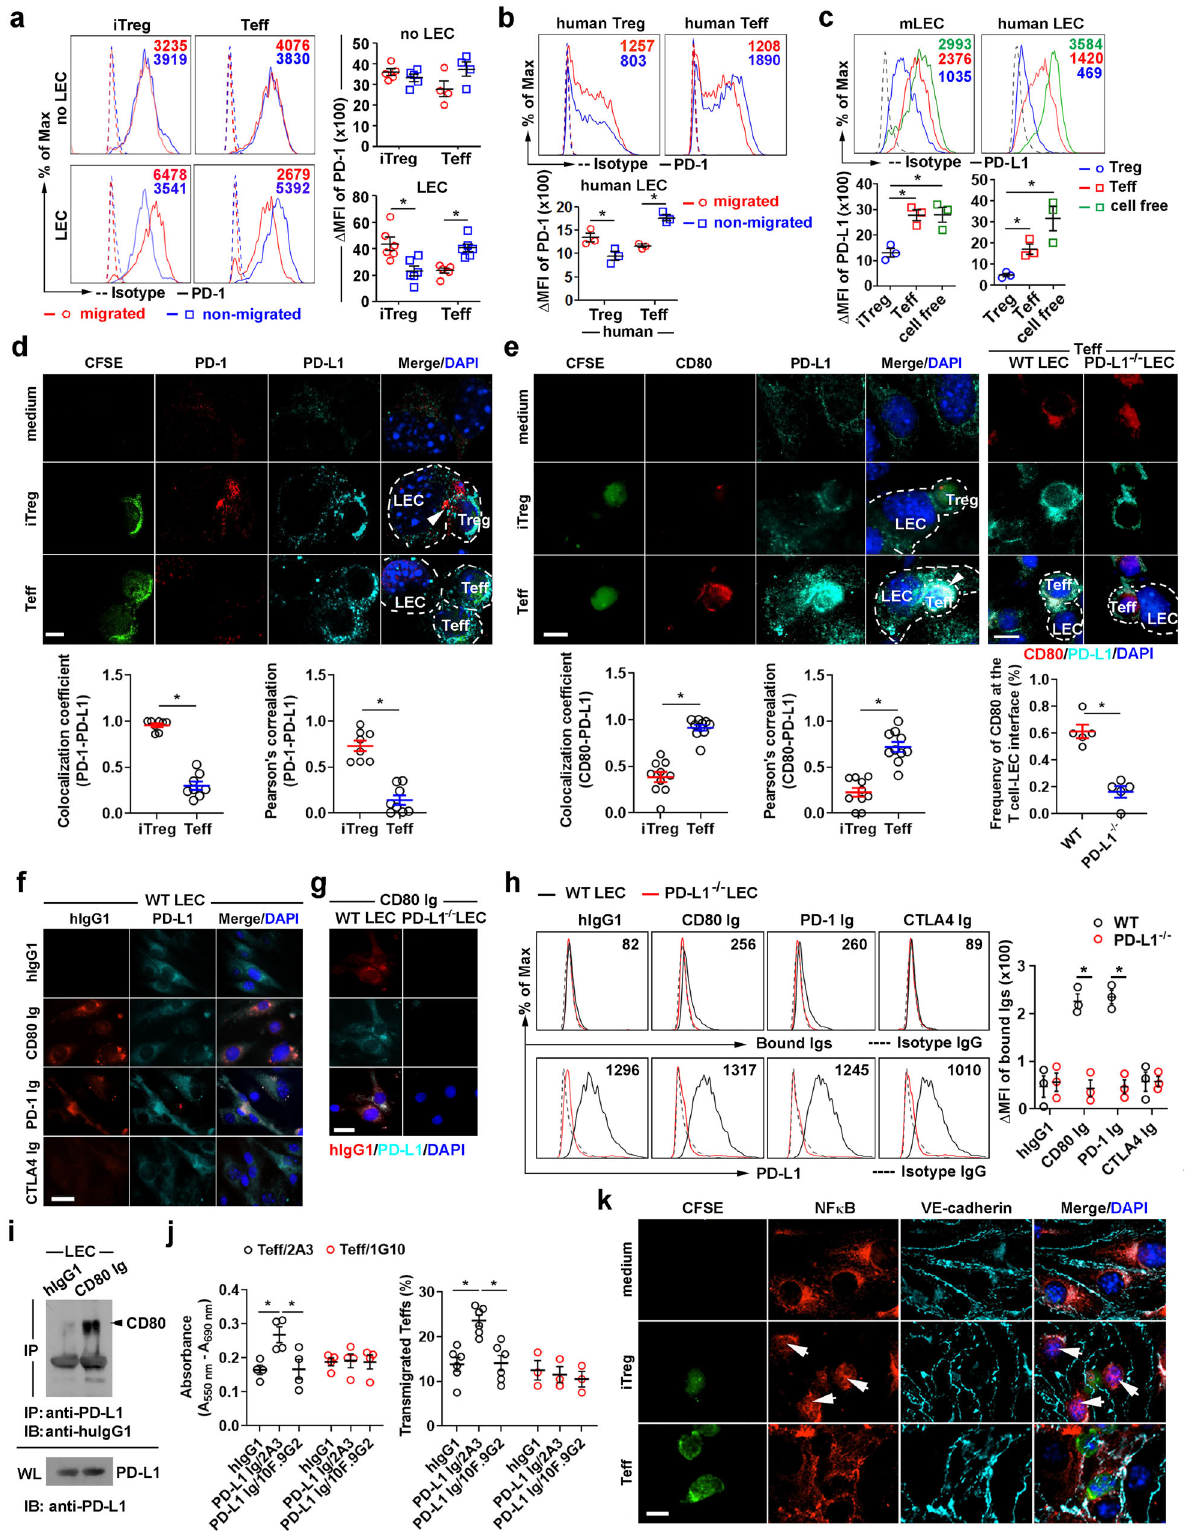
(Supplementary Fig. 5a-d), suggesting that PD-1 or CD80 blockade did not alter Treg proliferation but did promote CD4 Teff or non- Treg proliferation. In dLNs, there was no alteration of Treg pro- liferation, while non-Treg CD4 T cells had increased proliferation after PD-1 blockade (Fig. 7a, Supplementary Fig. 5e, f). PD-1 blockade increased tumor in fi ltration by both CD4 and CD8